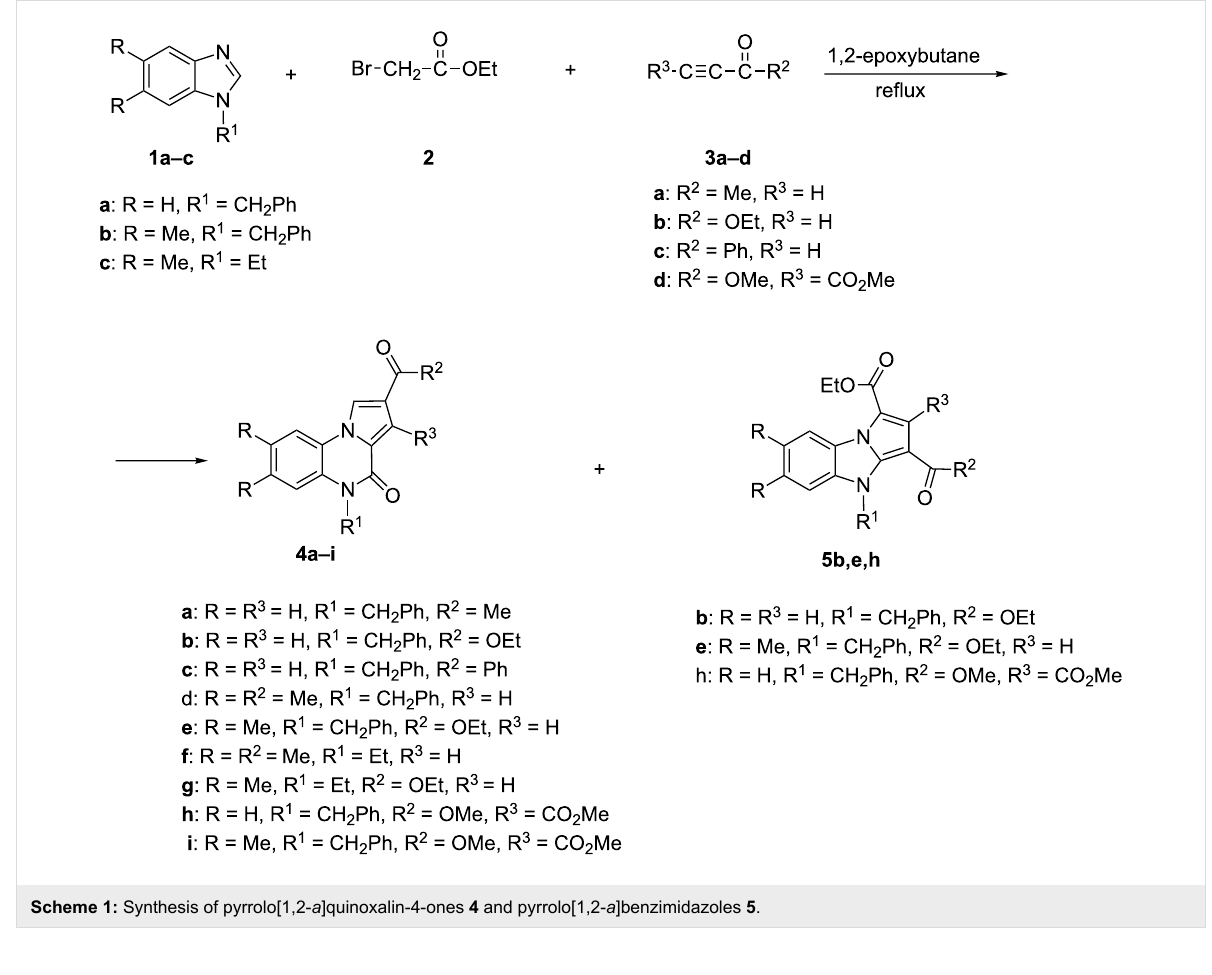
Table 1: Synthesized pyrrolo[1,2- a ]quinoxalin-4-ones 4 and pyrrolo[1,2- a ]bezimidazoles 5